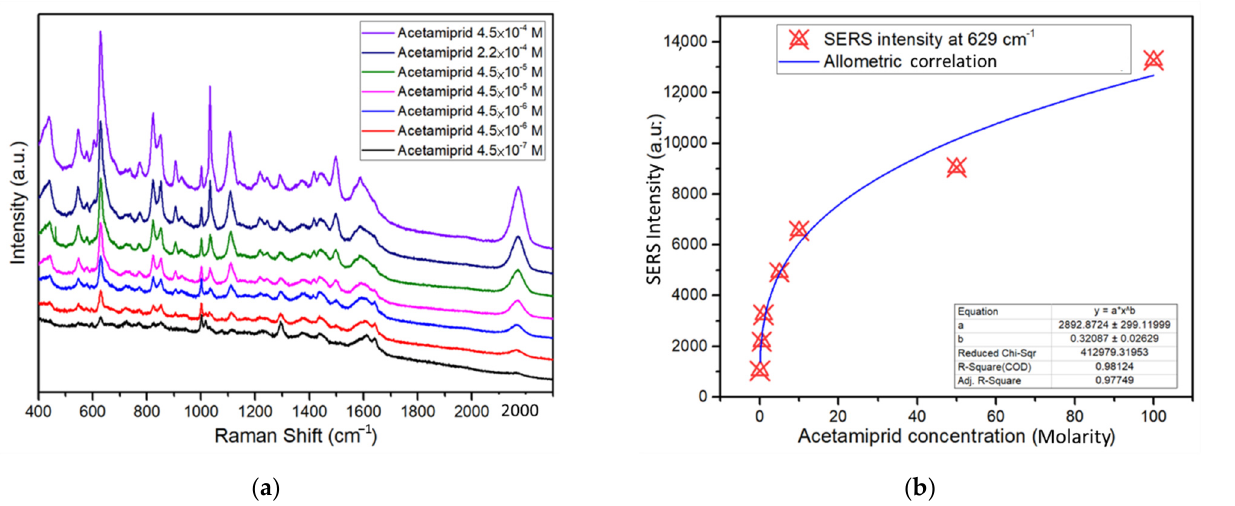
Figure 7. ( a ) SERS detection of various concentrations of acetamiprid with Ag@ZnO-ITO synthe- sized with an irradiation time of 60 min. ( b ) EF for various concentrations of